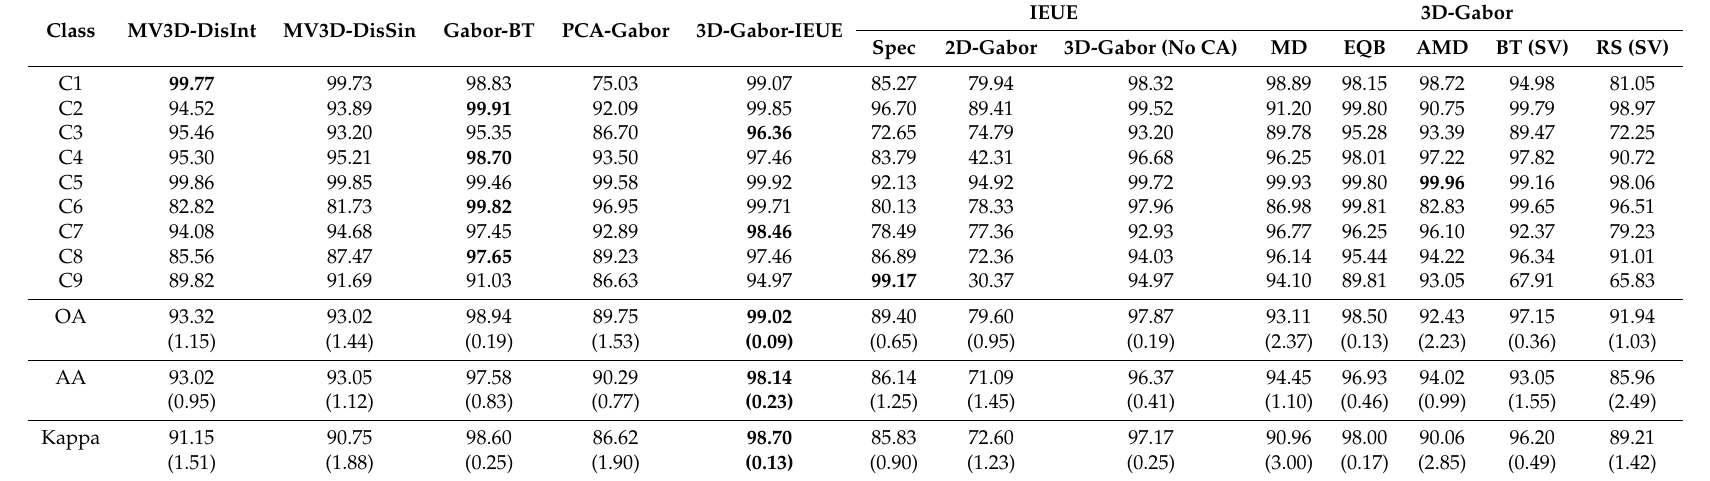
Table 5. Classification accuracies [ % ] of different view generation and sampling selection methods for the University of Pavia dataset, using 45 initial training samples (5 per class) and 240 selected samples. For PCA-Gabor, 288 samples (32 per class) are used for training. The numbers in parenthesis are standard deviations. Bold values indicate the best result for a